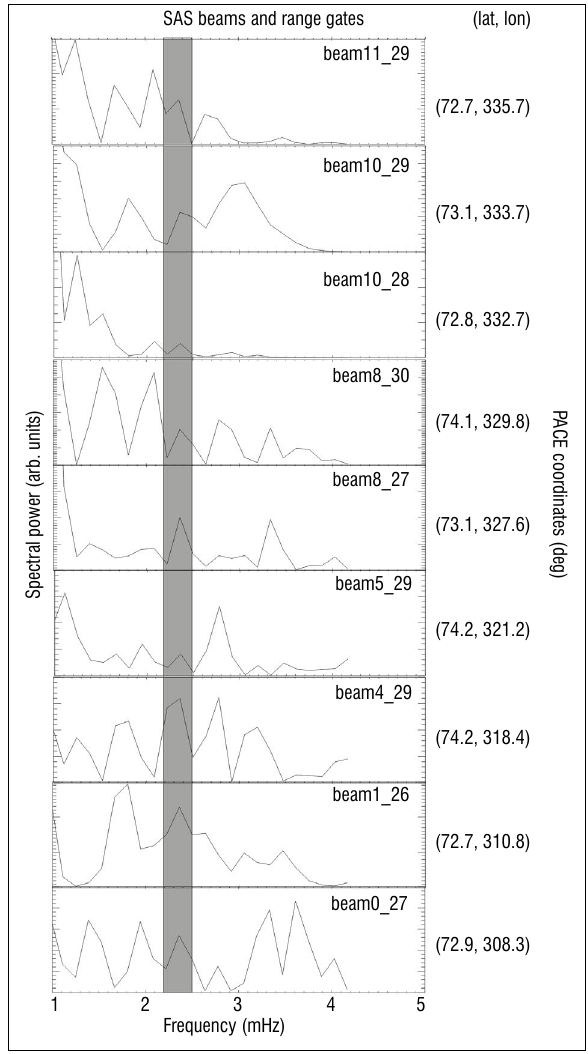
GBR beams and range gates